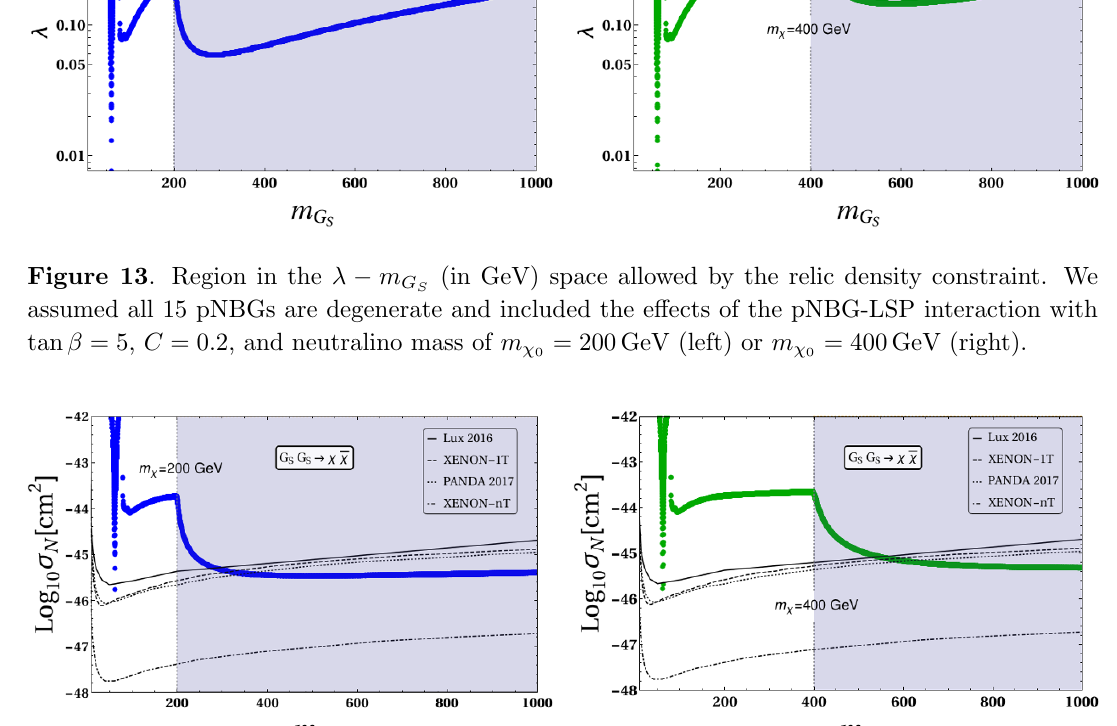
Figure 14 . Direct search constraints for relic density allowed pNBG DM parameter space with non- negligible pNGB-neutralino interaction. LUX 2016 [54], XENON 1T [55], PANDA X [56] bounds and future prediction of XENONnT [57] are shown. MSSM parameters are chosen as tan (cid:12) = 5, C = 0 : 2 and neutralino mass m (cid:31) = 200 GeV (left), m (cid:31) = 400 GeV (right). 0 0